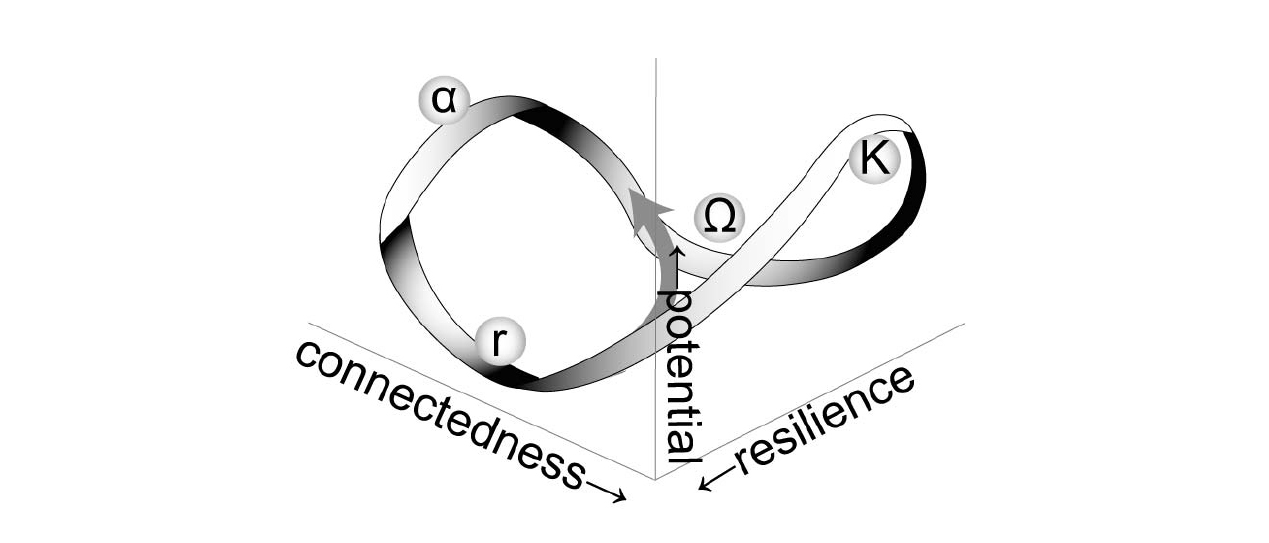
Fig. 4. Conventional farming short-circuits the adaptive cycle. The dynamics are characterized by fast feedbacks. Frequent disturbances prevent the system from developing recycling mechanisms in ecosystems associated with a high potential. The high inputs during the reorganization ( a ) phase enable a high potential and